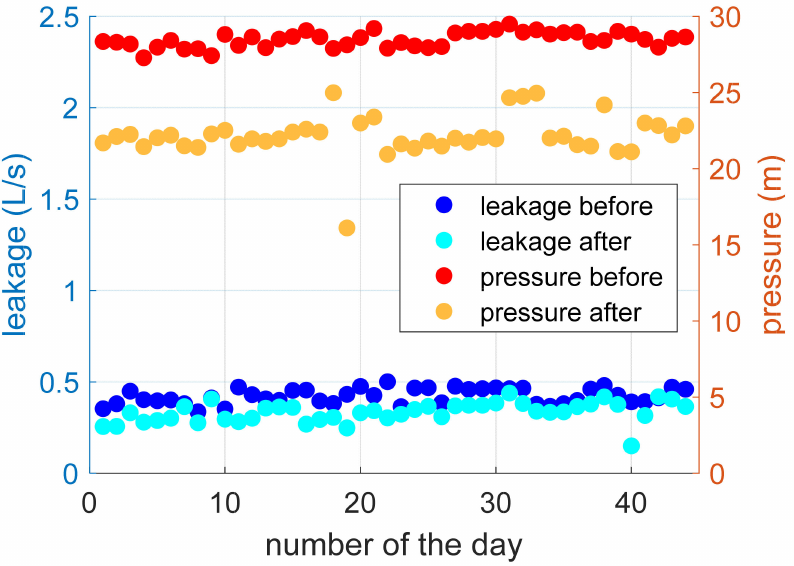
Figure 5. Values of pressure before ( red ) and after ( orange ) the pressure reduction maneuver and values of leakage before ( blue ) and after ( light blue ) the same maneuver, which were extrapolated from the hourly time series for each of the 45 days of monitoring indicated on the x